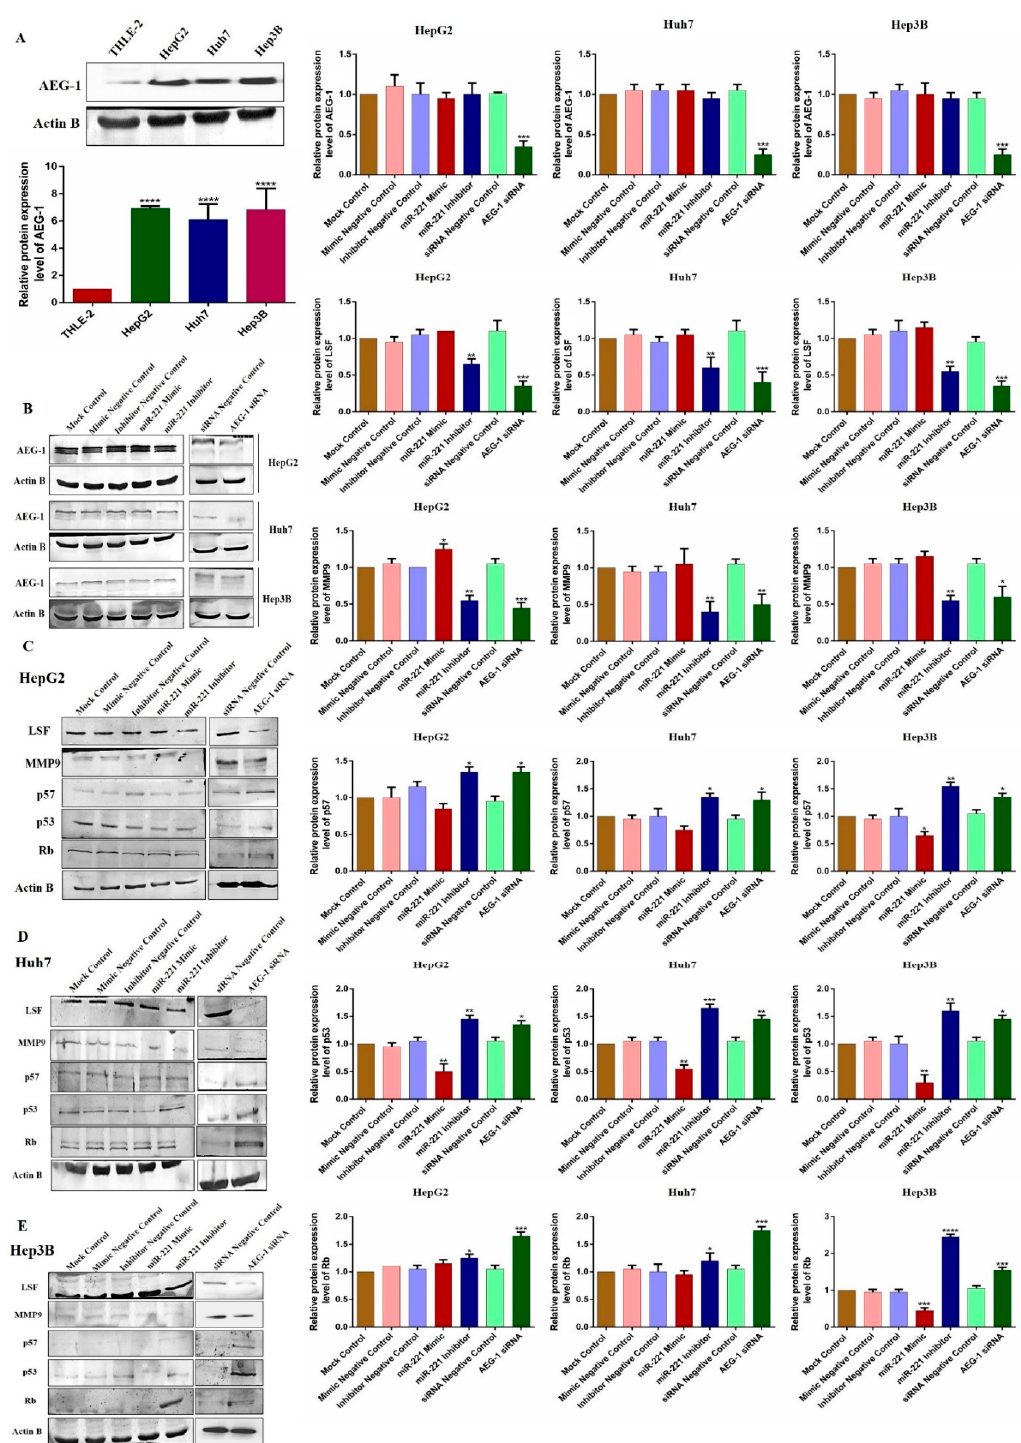
Figure 7. The effect of AEG-1/miR-221 was analyzed on cell cycle and angiogenesis regulatory proteins in HCC cell lines. The relative AEG-1 protein expression in THLE-2, HepG2, Huh7, and Hep3B cells ( A ) and miR-221 mimic-, miR-221 inhibitor-, and AEG-1 siRNA-transfected HCC cells ( B ). The regulatory protein expressions which regulate angiogenesis (LSF and MMP 9) and cell cycle (p57, p53, and RB) were analyzed in miR-221 mimic-, miR-221 inhibitor-, AEG-1 siRNA-, and their controls-transfected HepG2 ( C ), Huh 7 ( D ), and Hep3B ( E ) cells by western blot. p -Values presented as * p < 0.05, ** p < 0.01,*** p < 0.001, **** p < 0.0001 and error bars presented as the mean ± s.d. ns—(non-significant) compared to the